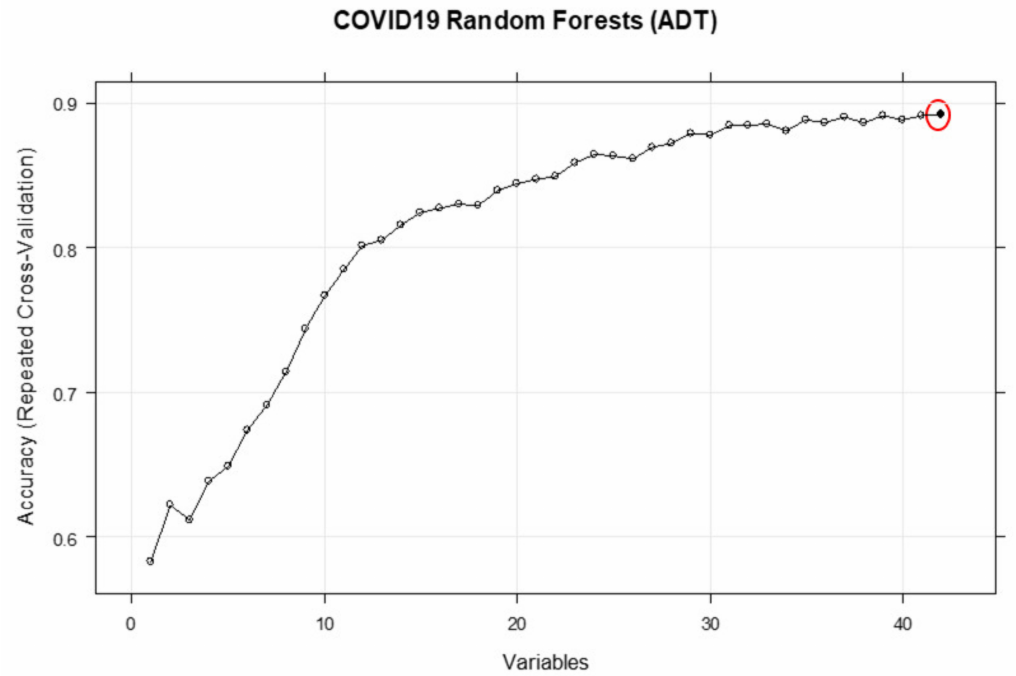
Figure 3. Performance of the RFE based on the ranks of the features of ADT. The red circle shows the maximum achievable performance based on the best combination of